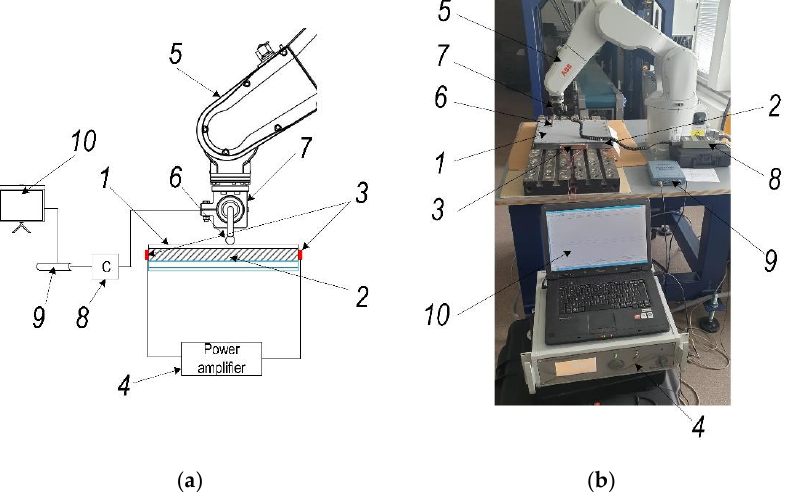
Figure 4. Experimental set-up for sample excitation: 1 — aluminum alloy sheet; 2 — metal frame; 3 —